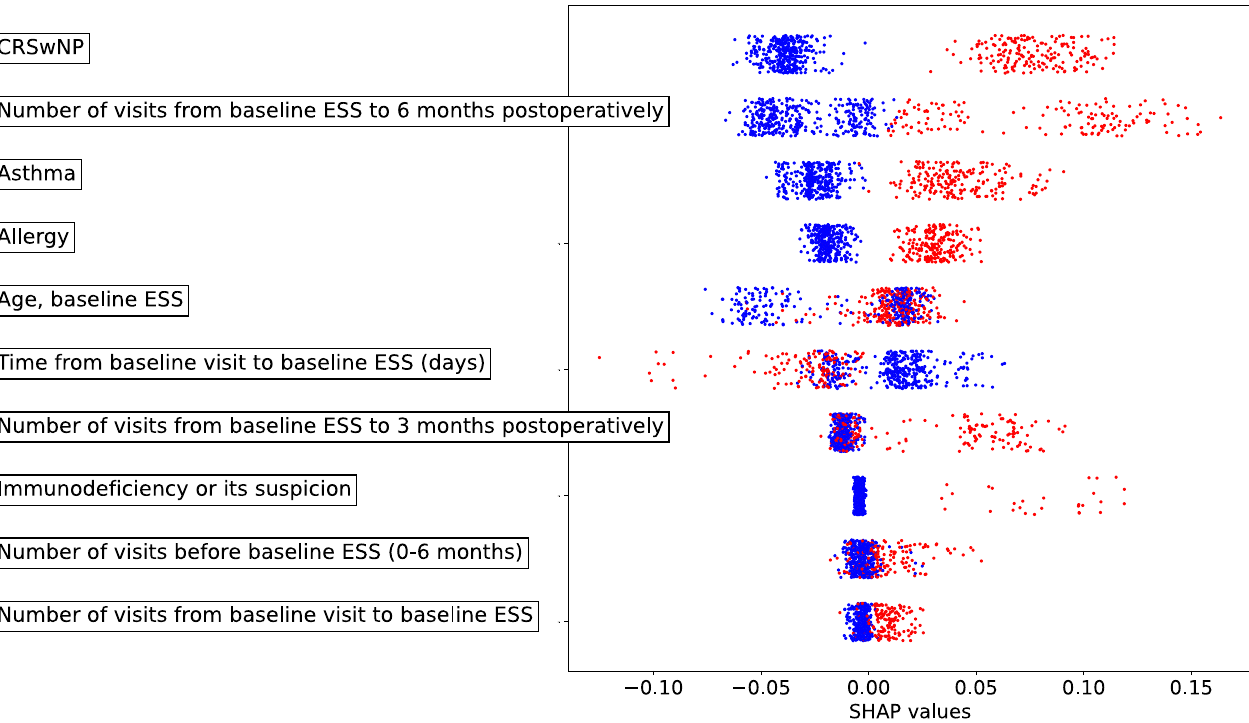
Fig 6. Shapley values (SHapley Additive exPlanations, SHAP) for the ten most important variables predicting revision ESS. The gradient boosting algorithm was used as the classifier. The definition of the ten most important variables is based on the sum of the absolute Shapley values. The red points indicate higher patient-specific variable values than the average value of the variable and, the blue points indicate lower patient-specific variable values than the average value for the variable. A longer distance between a red and blue point indicates a better capacity of the variable to predict revision ESS. ESS, endoscopic sinus surgery; CRSwNP, chronic rhinosinusitis with nasal